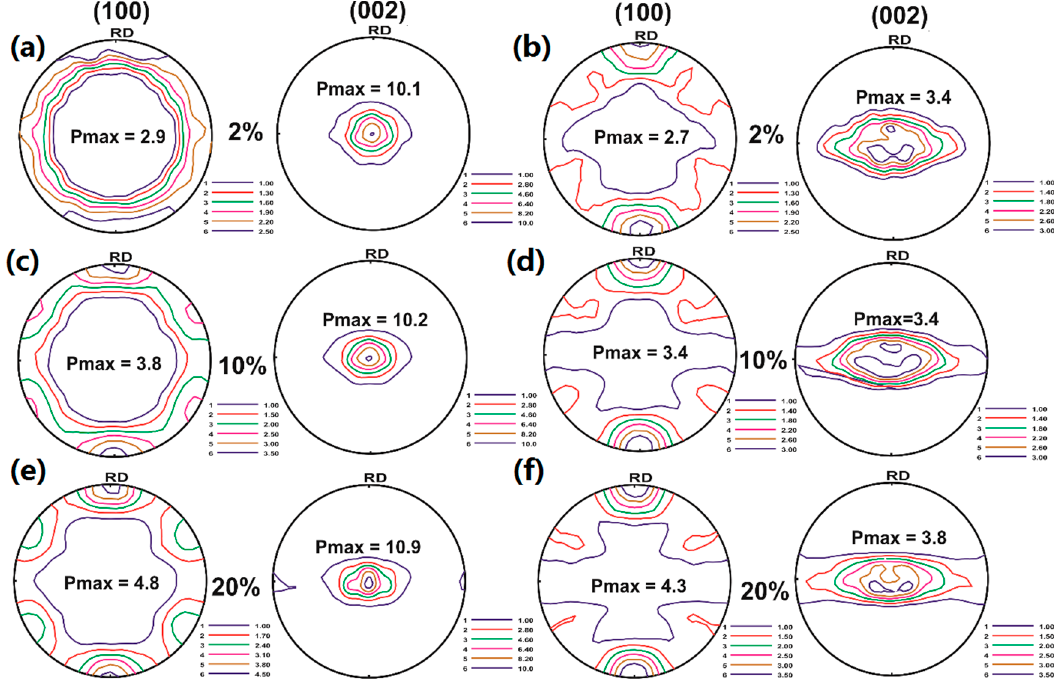
Figure 7. Texture development during tension along RD at different strain: ( a ) Z1 at 2%; ( b ) ZN10 at 2%; ( c ) Z1 at 10%; ( d ) ZN10 at 10%; ( e ) Z1 at 20%; ( f ) ZN10 at 20%.